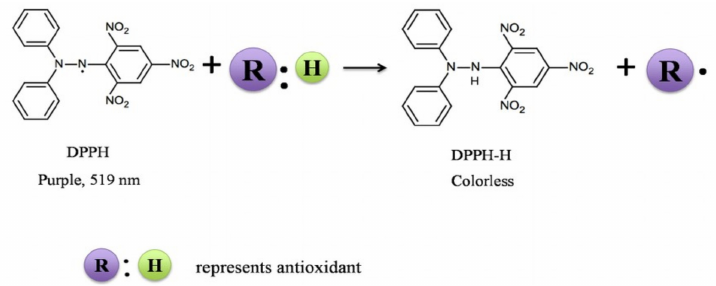
Figure 3. Changes in the DPPH radical-scavenging